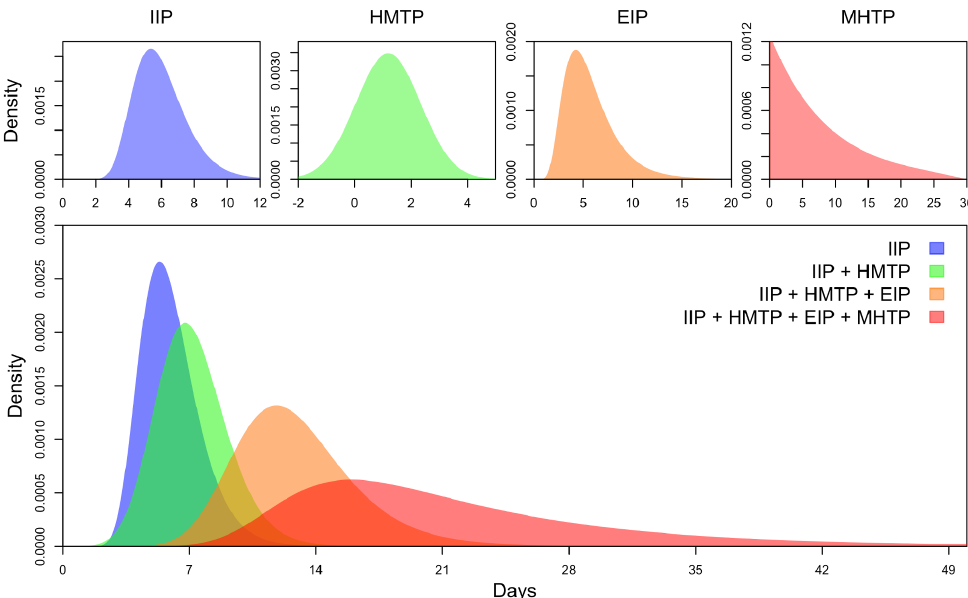
Fig 1. Random variables associated with components of the transmission cycle (top) and their successivesums (bottom). On the top, the intrinsic incubation (IIP), human-to-mosquito transmission period (HMTP), extrinsic incubationperiod(EIP), and mosquito-to-humantransmissionperiod(MHTP) are shown from left to right, with the latter two parameterized for a temperatureof 30˚C. On the bottom, random variables for the elapsedtime betweeninoculationof the primary infectionand each event in the transmission cycle is shown in successiveorder from left to right.